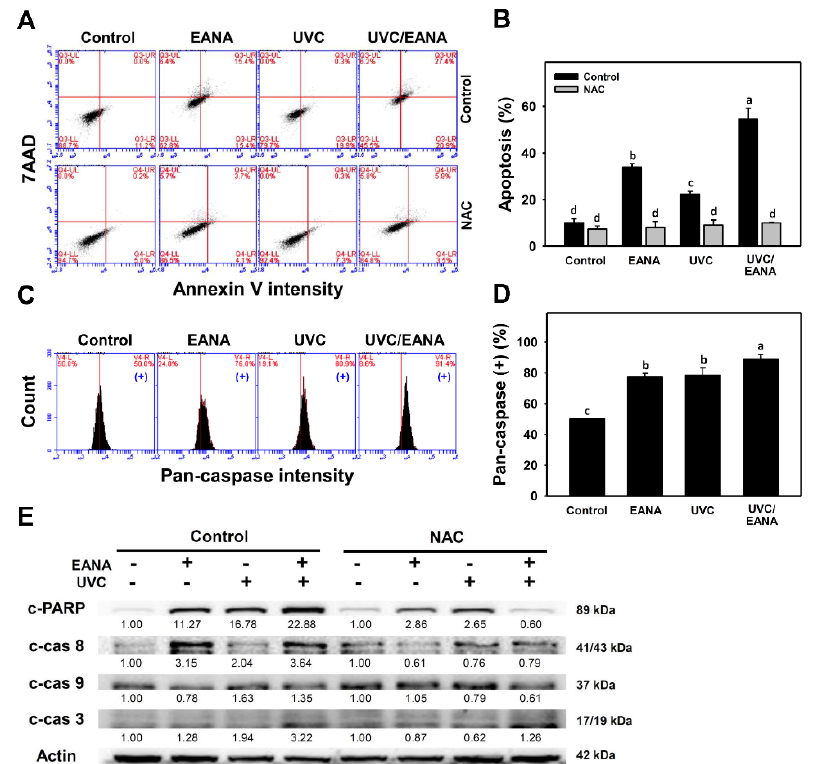
Figure 3. Apoptosis analyses of EANA and/or UV treatments for human oral cancer Ca9-22 cells. With or without NAC (10 mM) pretreatment for 1 h, cells were post-treated with control (DMSO only), EANA (5 µg/mL), UVC (12 J/m 2 ), and combined treatment (UVC/EANA) for 24 h. ( A ) Typical flow cytometry patterns for the annexin V/7AAD method. Annexin V-positive regions were counted for apoptosis (%). ( B ) Statistical analysis for (A). ( C ) Typical flow cytometry patterns for pancaspase method. Pancaspase intensity-positive regions were marked as (+). ( D ) Statistical analysis for (C). Treatments showing no overlapping labels (a–d) differ significantly between multiple comparisons ( p < 0.001–0.0001). Data, mean ± SD ( n = 3). ( E ) Western blotting for apoptosis signaling proteins.